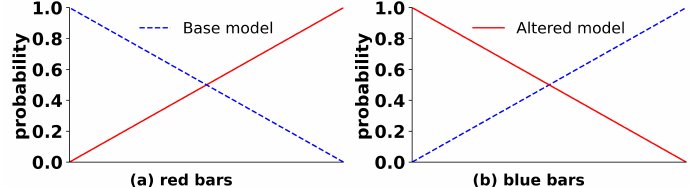
Figure 6. Probability of sampling during the periods of gradual